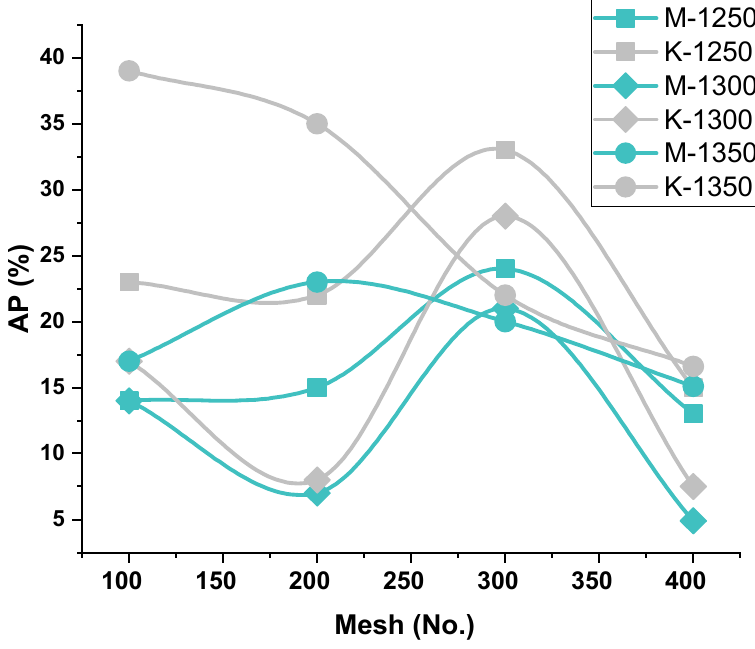
Figure 4. Effect of (Mesh no.) fineness on A.P. of iron ore No.1/No.2 pellets.